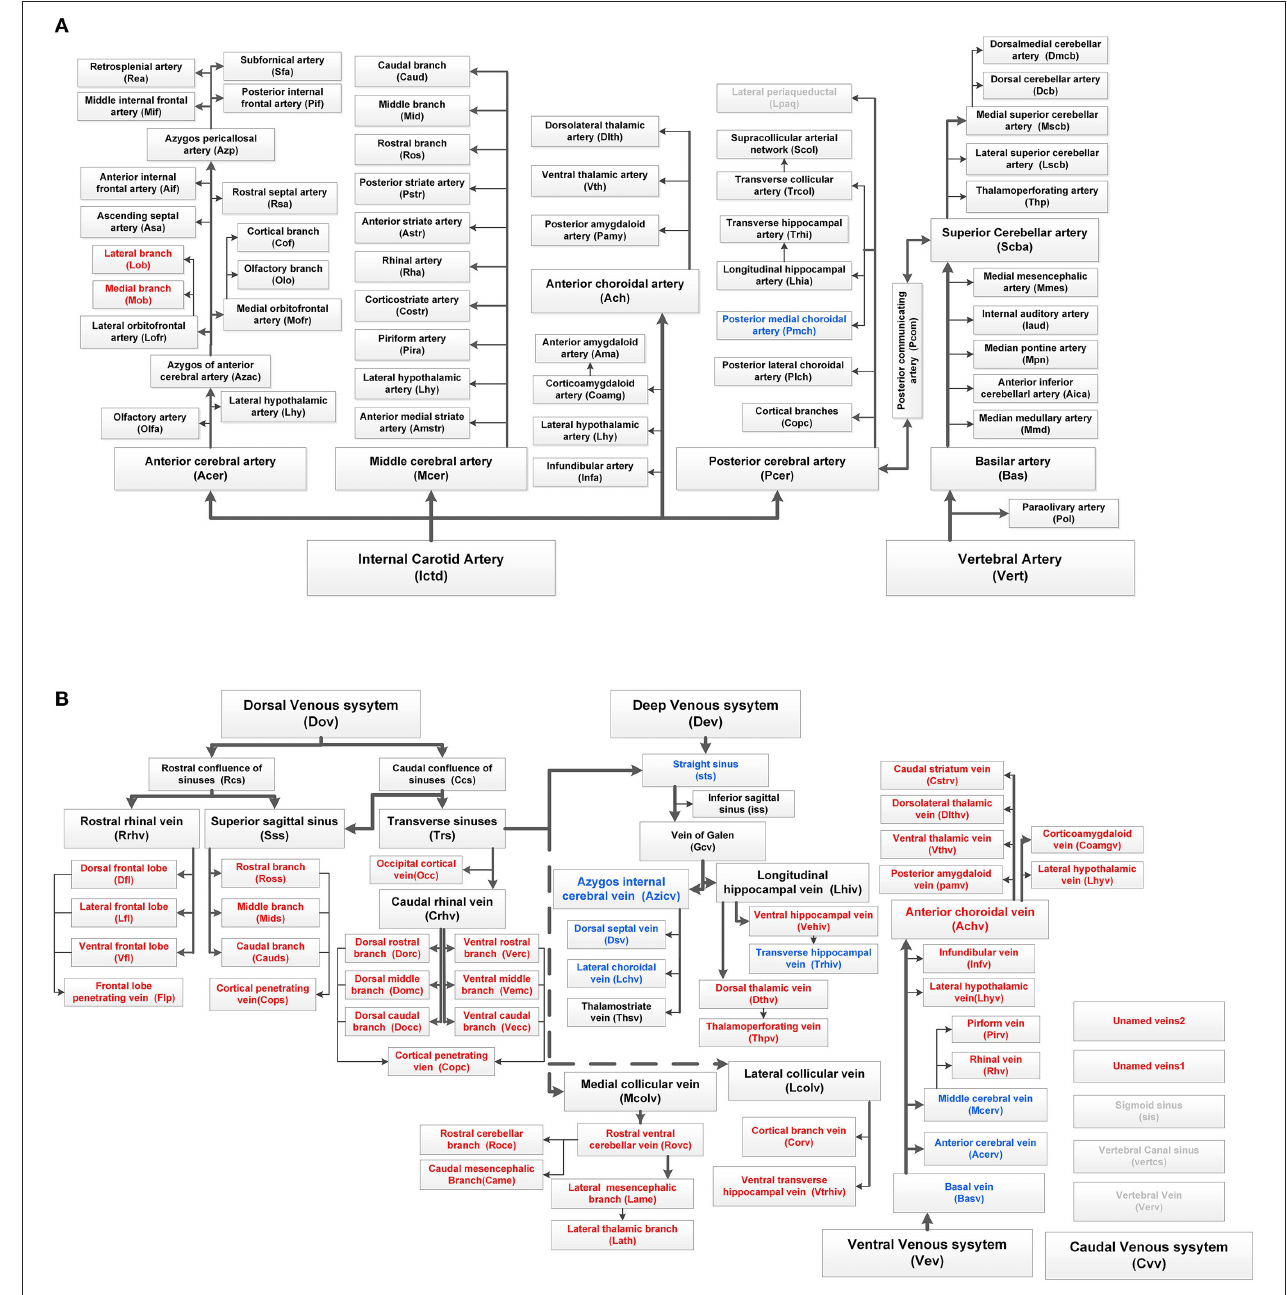
FIGURE 4 | Complete tree-like structures and annotations of the arterial and venous vascular system in the whole mouse brain. To ensure readability, the tree-like structure is arranged in the sagittal direction, in which left represents rostral, right represents caudal, up represents dorsal, and down represents ventral. The full names of vessels are presented in each box, and abbreviations are presented in brackets. (A) Tree-like structure of the arterial system. (B) Tree-like structure of the venous system. Vessels in black indicate the reported branches of the mouse brain vascular system study. Vessels in blue indicate the branches reported in the rat brain vascular system study but not reported in the mouse brain. Vessels in red indicate the branches not reported in the rat or mouse brain. Vessels in gray indicate the missing branches in our data.